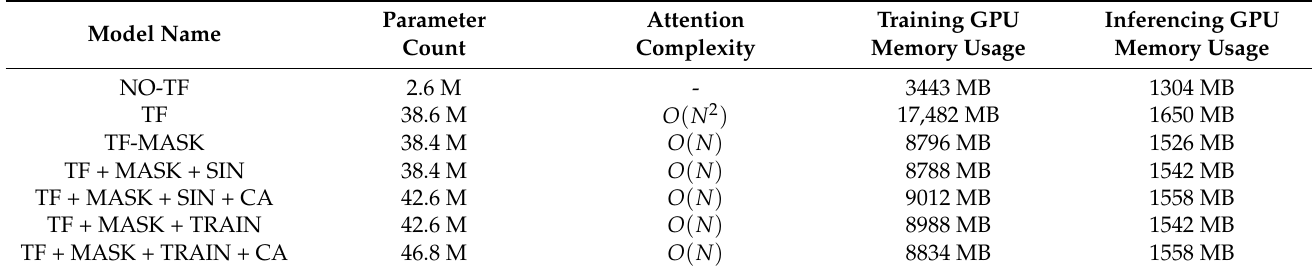
Table 10. Computational cost of different kinds of CST